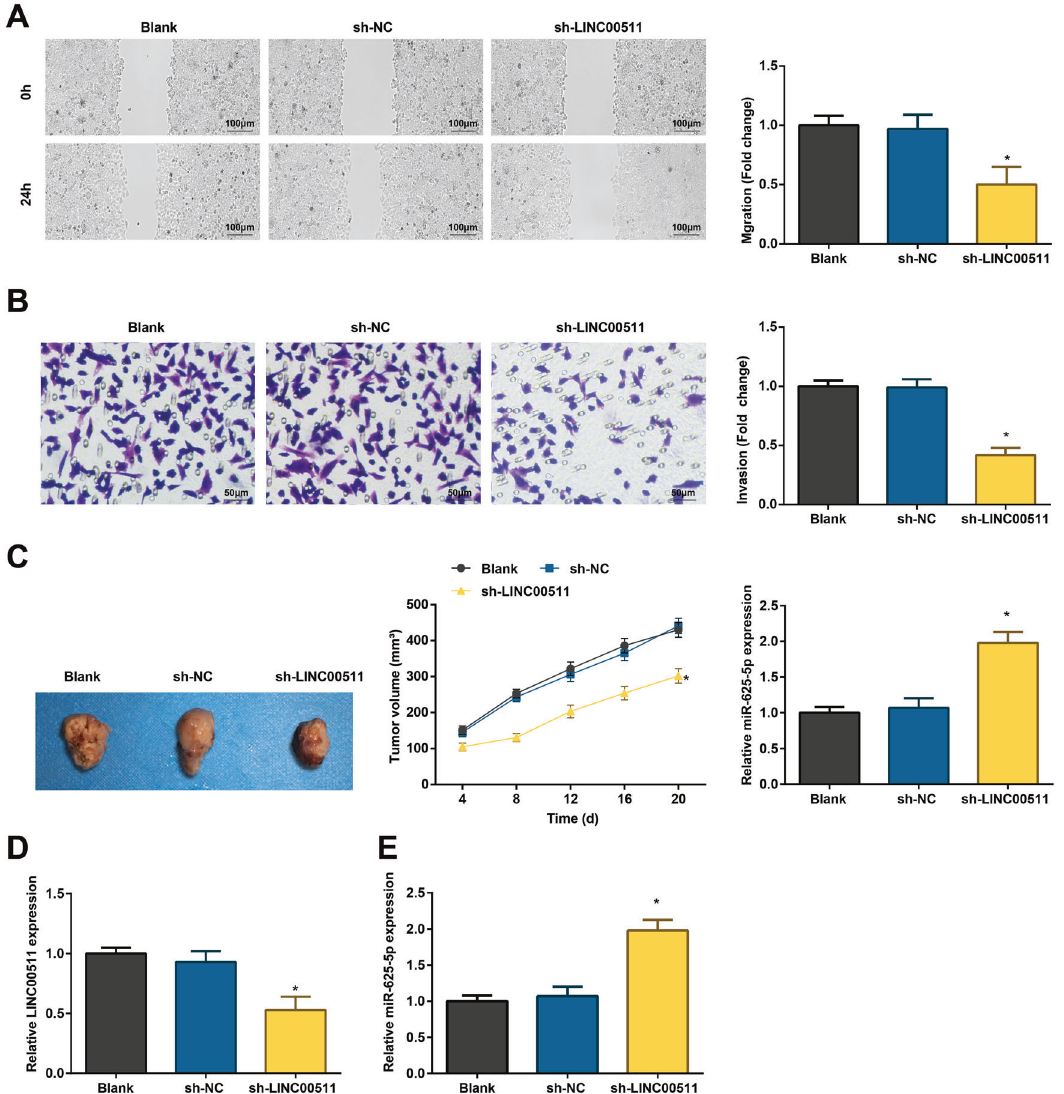
Fig. 3 LINC00511 knockdown impairs CC cell migration and invasion and cellular growth in mice. A Scratch test detected migration ability of CC cells; B Transwell assay detected invasion ability of CC cells; C xenografted tumor volume and weight; D RT-qPCR detected LINC00511 expression in tumors; E RT-qPCR detected miR-625-5p expression in tumors; the measurement data are expressed as mean ± standard deviation. N = 3. * P < 0.05 compared with the sh-NC